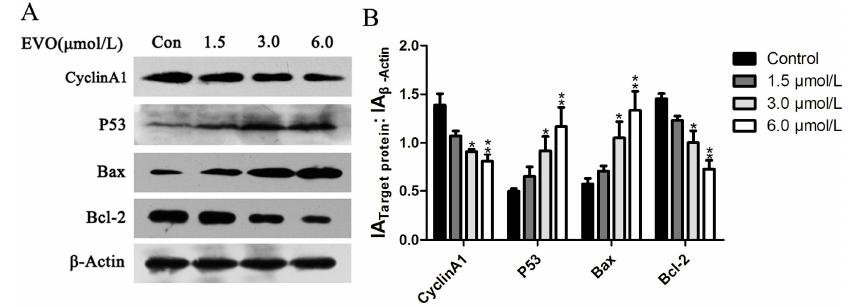
Figure 2. The effects of EVO on Cyclin A1 and the p53 signaling pathway. ( A ) HCT-116 cells were treated with the EVO for 48 h, and Cyclin A1 and p53 signaling pathway proteins were detected by Western blotting; ( B ) The relative expression ratio was calculated with Gray-scan value. The data shown represent mean ± SD ( * p < 0.05, ** p < 0.01).